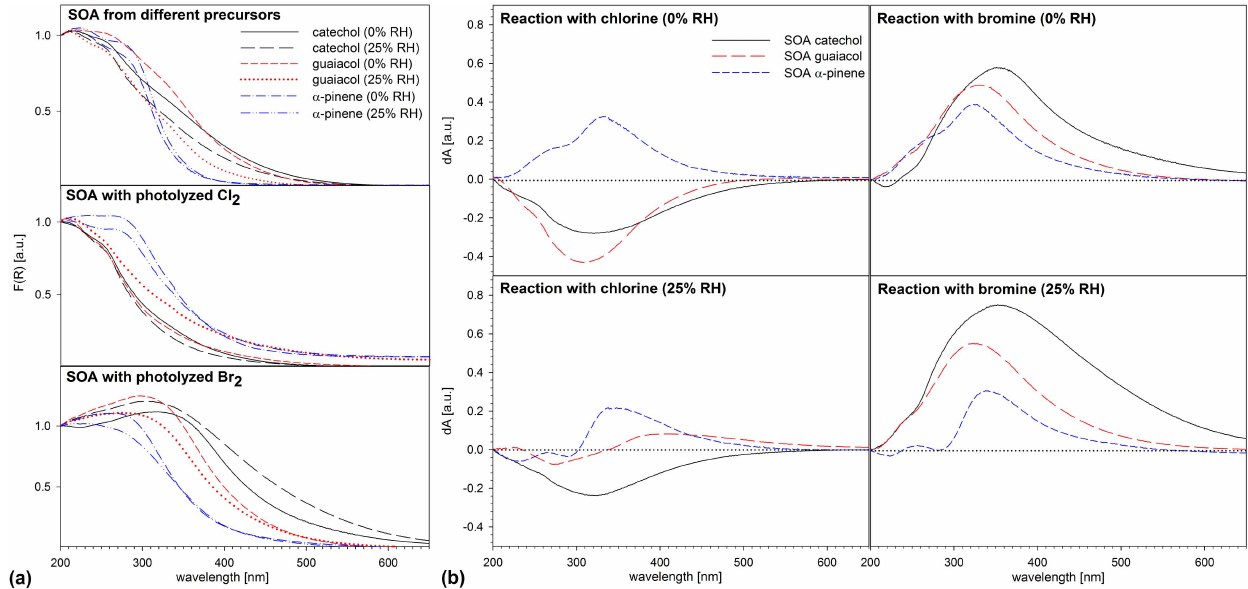
Fig. 3. Single absorption spectra F(R) (a) and change of the differential absorbance (dA) (b) in the UV/VIS spectra region due to the reaction of SOA with RHS formed from photolysis of molecular chlorine or